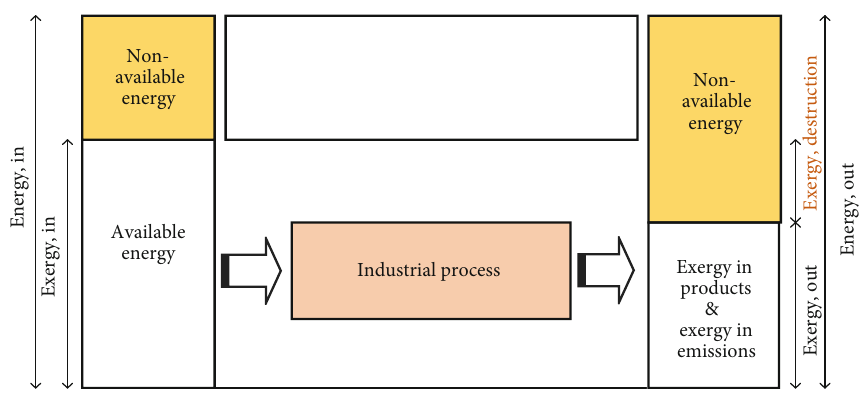
Figure 4: Basic concept of the overall balance of energy and exergy